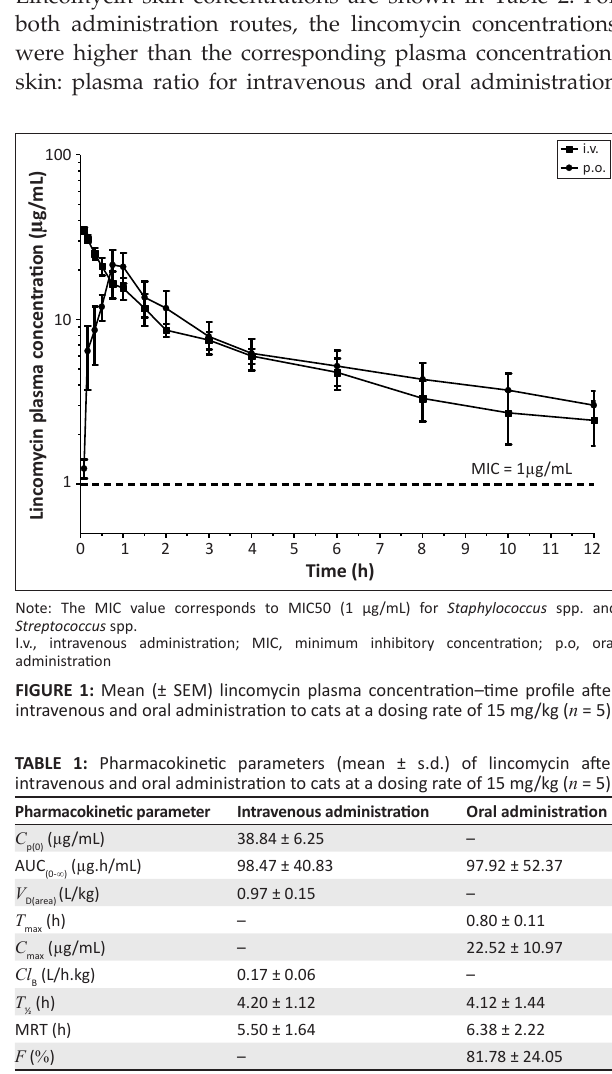
administration routes are summarised in Table 1.